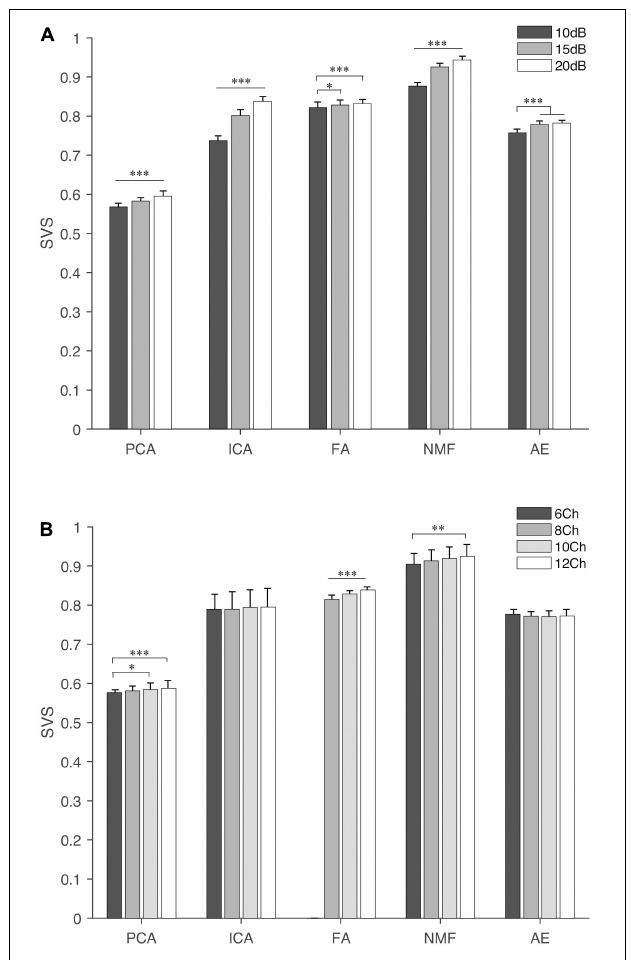
FIGURE 5 | The SVS of extraction methods under different settings, (A) SNR and (B) NoC. The fine line on the bar is the standard error between trials. “ ∗ ”, “ ∗∗ ”, and “ ∗∗∗ ” indicate the significance levels are 0.05, 0.01, and 0.001,